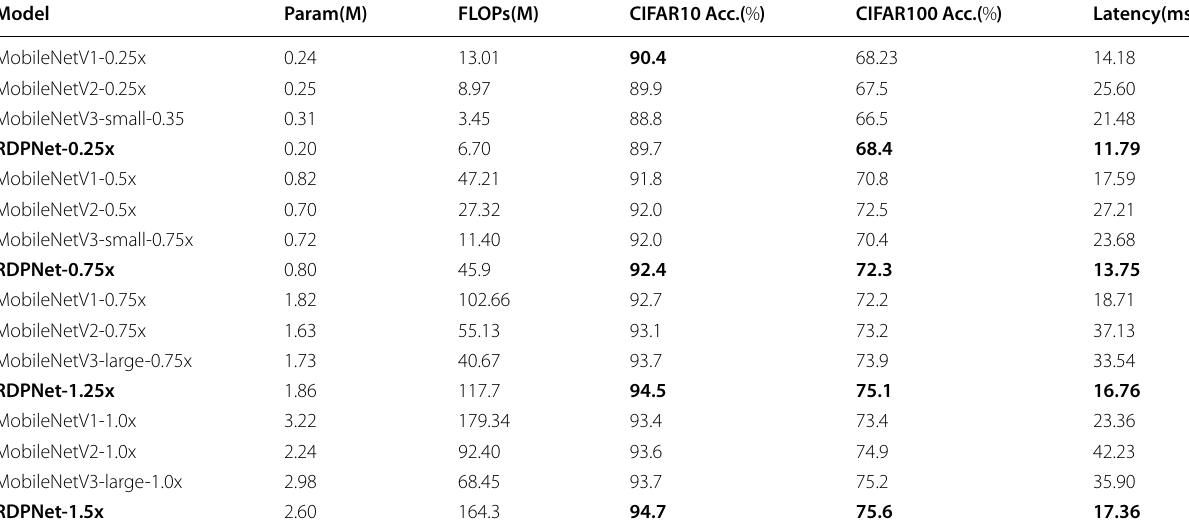
Table 5 The performance of some RDPNet models on